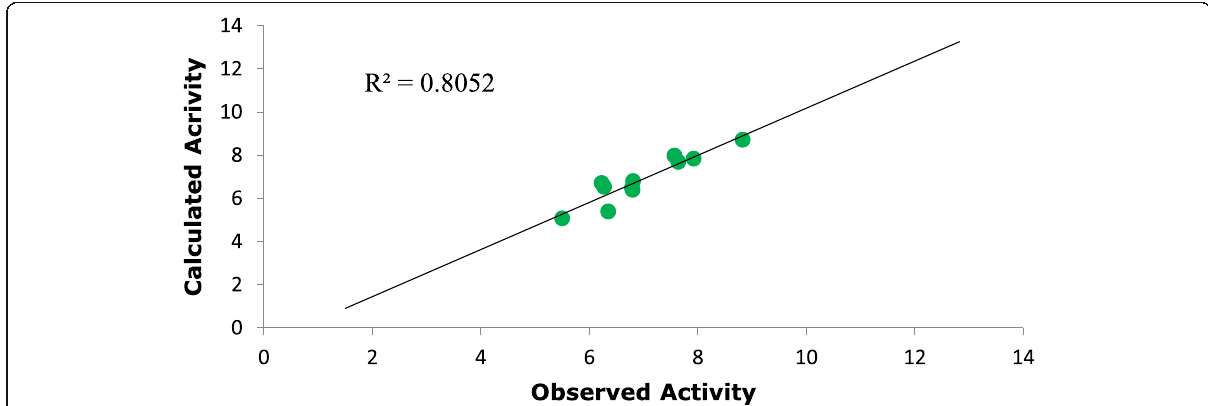
Fig. 2 Plot of predicted activity against observed activity of test